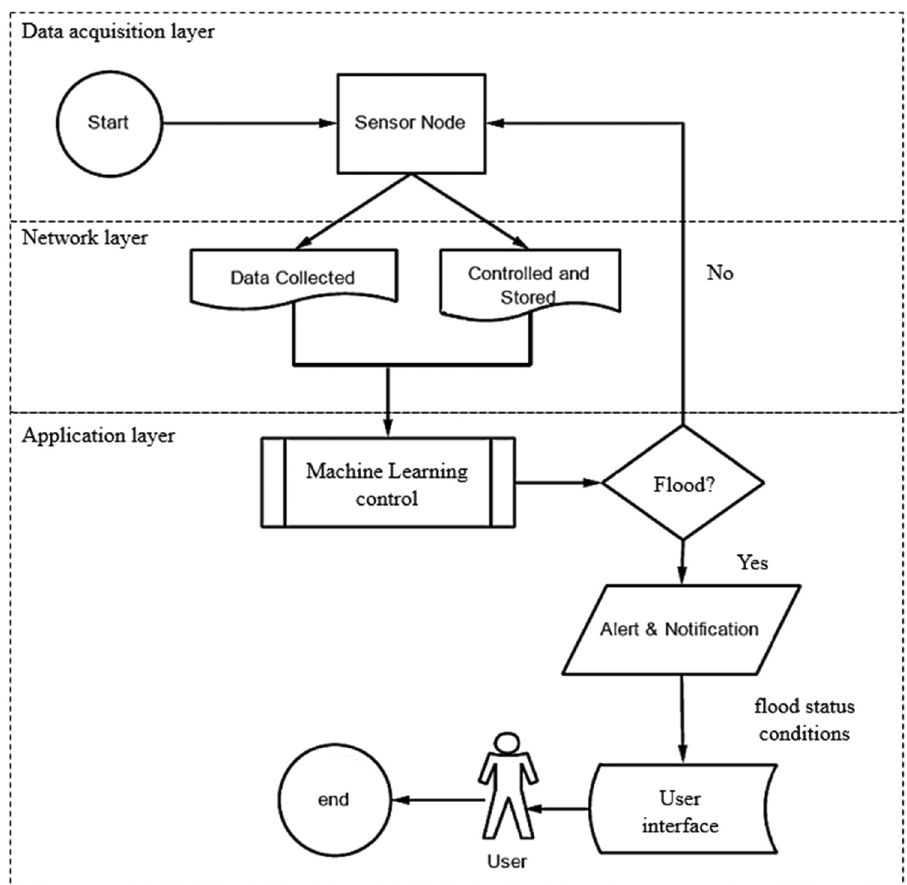
Figure 3: The IoT - FSP model based on the IoT